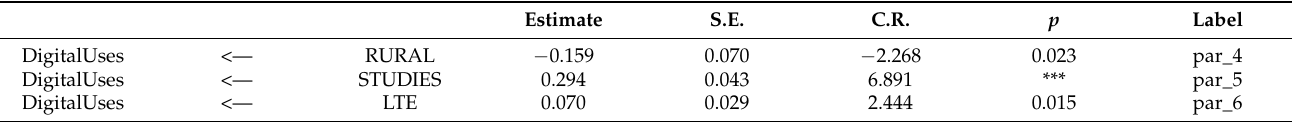
Table A16. Regression Weights: (Group number 1-Default model).